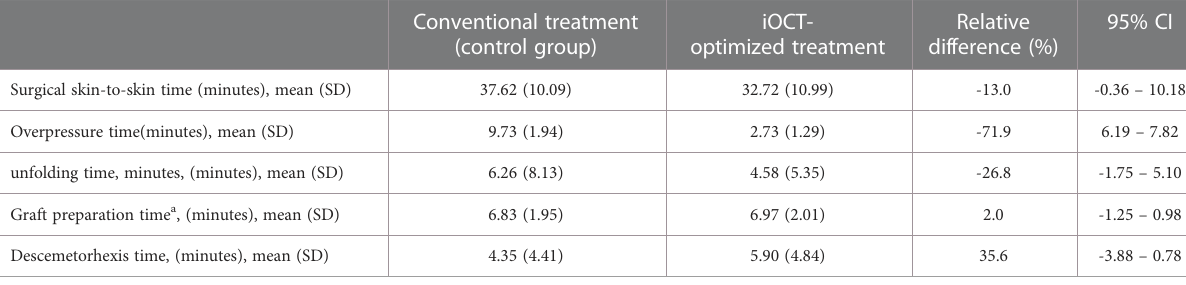
TABLE 3 Overview of surgical times Manually scored and video-graded by two independent